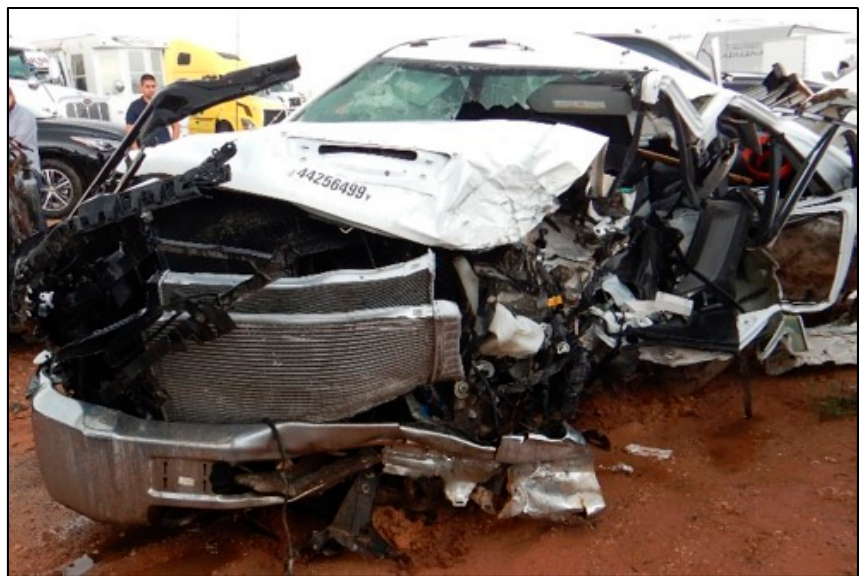
Figure 4. The decedent’s Chevrolet post-collision (photograph taken at a wrecking yard).